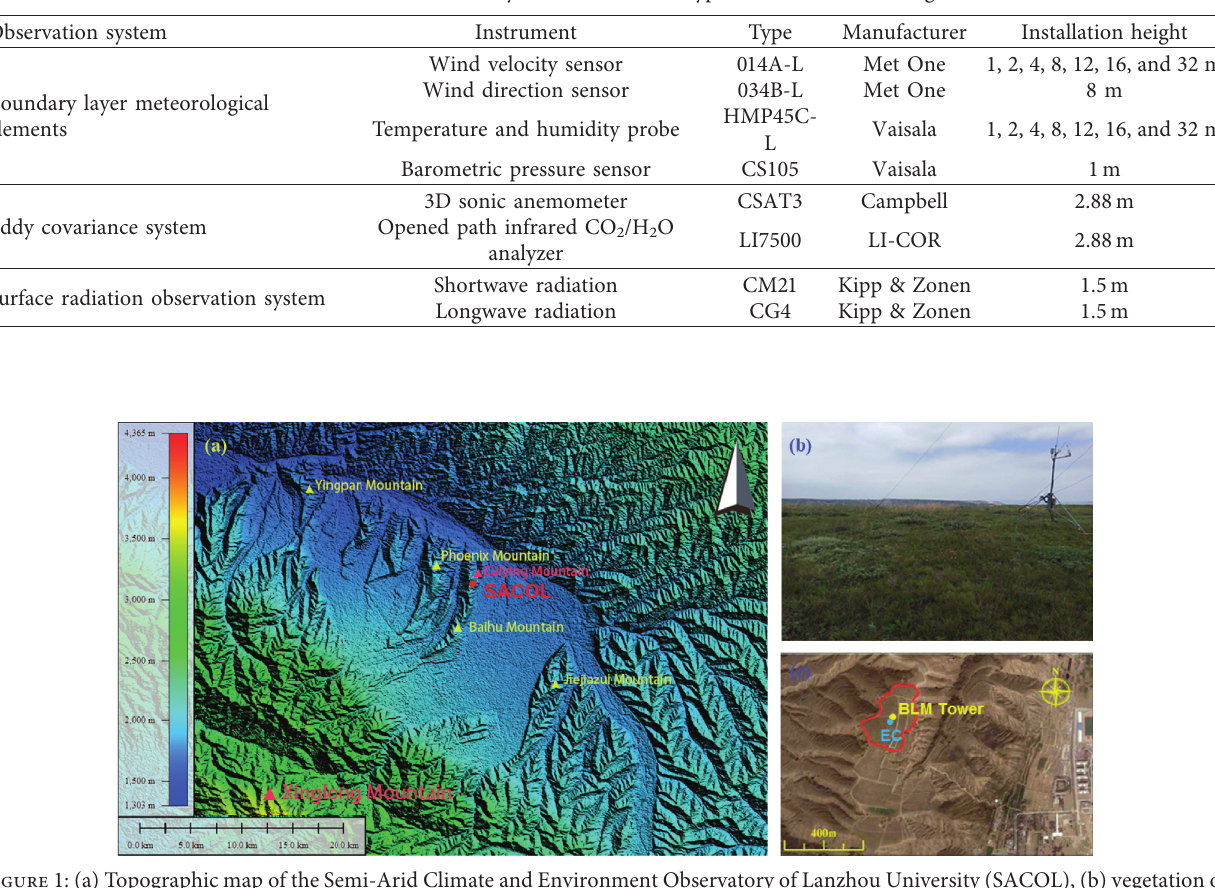
Table 1: Main observation systems, instrument types, and installation heights.